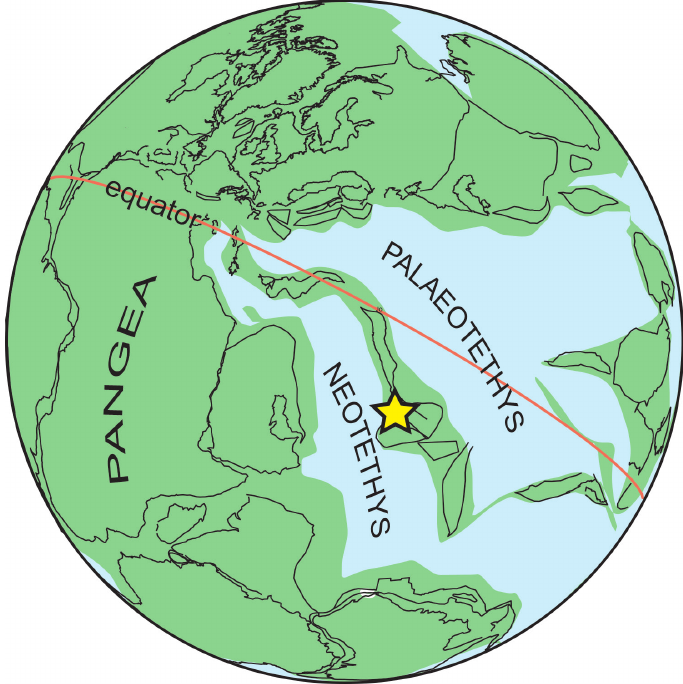
Fig. 2. Palaeogeographic position of the Baghuk Mountain area (after Stampfli & Borel